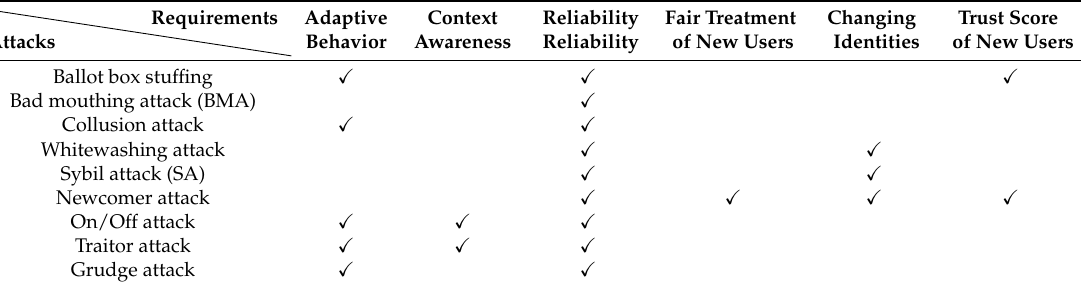
Table 3. WBAN trust management requirements for different